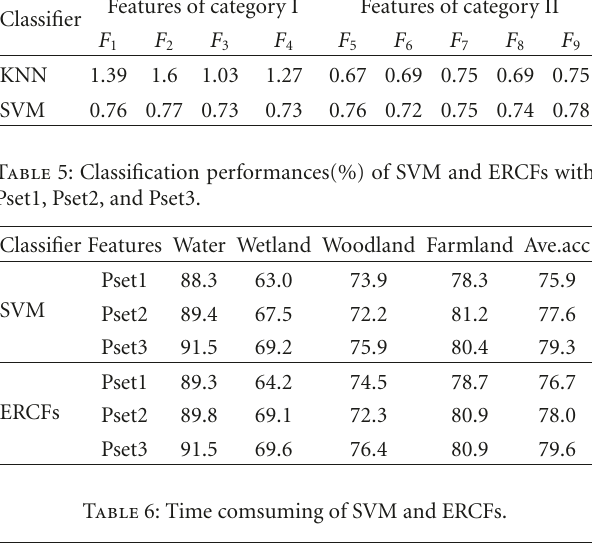
Table 2: Classification accuracies of single polarimetric descriptor using KNN and SVM classifier(%).